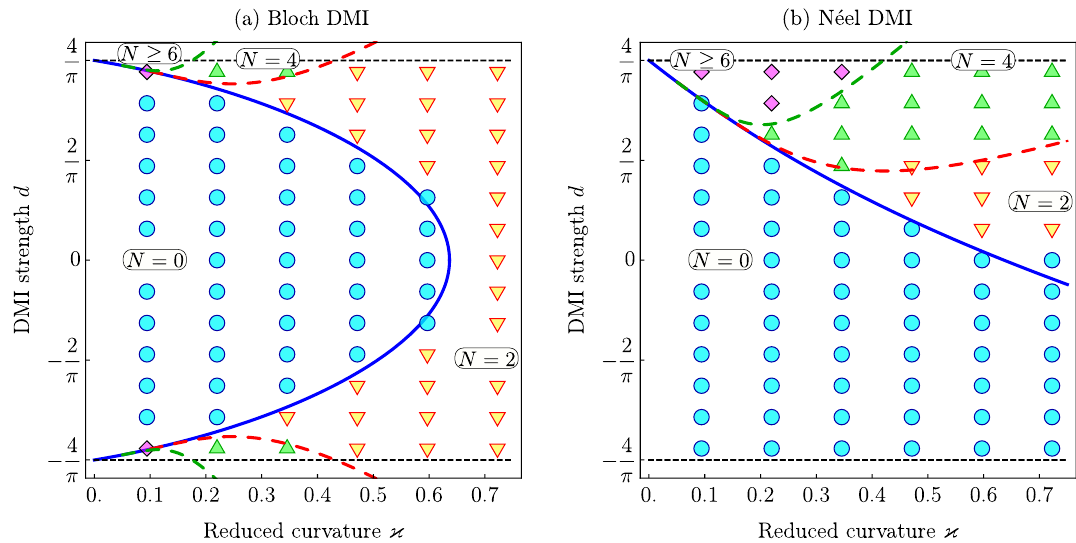
Figure 5: Equilibrium states in tubular shells with dipole-dipole interaction: (a) and (b) show phase diagrams of equilibrium states in tubular shell with Bloch and Néel type DMI, respectively. Symbols display the results of spin-lattice simulations: circles – normal (hedgehog) magnetization distribution ( m = ± n ); other symbols – periodic states (purple diamond correspond to states with q ≥ 3). Blue solid lines in (a) and (b) are analytical critical lines determined by Eqs. (8) and (12), respectively; dashed lines in (a) and (b) mark transitions between the periodic equilibrium states with different number of DWs, as determined by numerical solution of equations ( q ) = (cid:69) per ( q + 1 ) and (cid:69) per ( q ) = (cid:69) per ( q + 1 ) : q = 1 corresponds to red dashed line, (cid:69) per B B N N q = 2 – green. Dashed black horizontal lines correspond to critical DMI parameter = ± 4 /π in a flat systems d 0